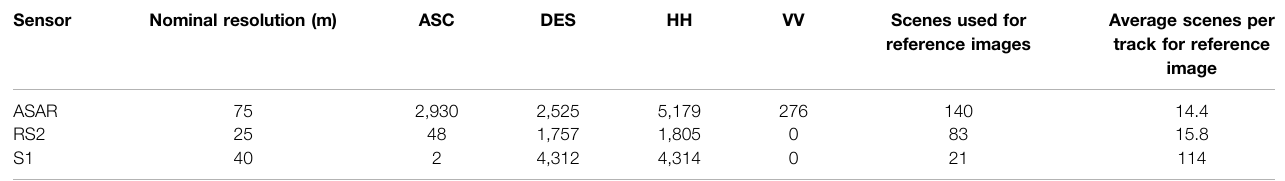
TABLE1| Numberofscenespersensor,geometry[ascending( “ ASC ” )/descending( “ DES ” )]andpolarization(HH/VV).Numberoftracksusedforreferencedatacalculations and average number of scenes per referece per track is also